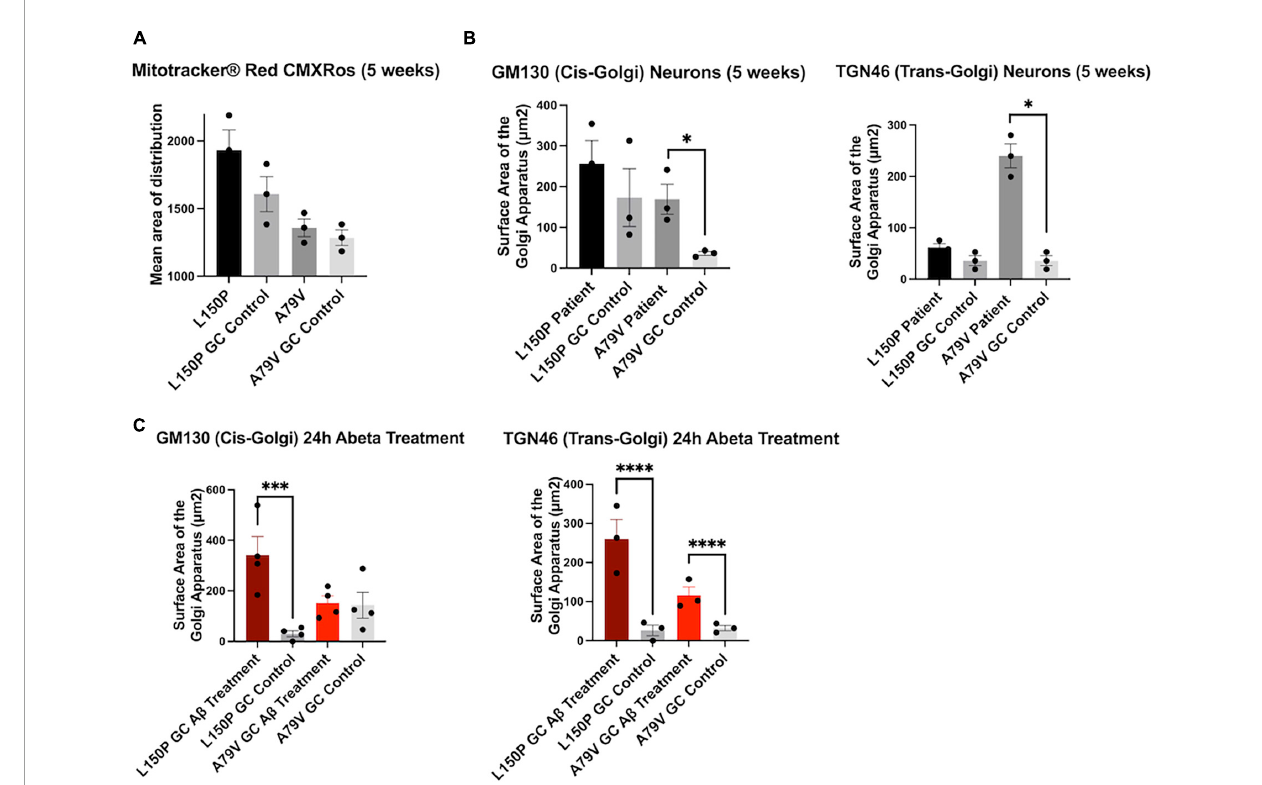
FIGURE4 Golgi fragmentation is an early event in AD pathogenesis, triggered by A β 42 peptides. (A) Quantitative assessment of MitoTracker TM , mean area of distribution, in five-week L150P and A79V hiPSC derived neurons. (B) Quantitative assessment of cis- and trans-Golgi surface area in five-week L150P and A79V hiPSC derived neurons. (C) Quantitative assessment of cis- and trans-Golgi surface area in isogenic controls, following a 24-hour A β treatment. Results are displayed as mean ± standard error of the mean (SEM) from three replicates. Significance levels are indicated by ∗ p < 0.05, ∗∗∗ p < 0.001, and ∗∗∗∗ p <